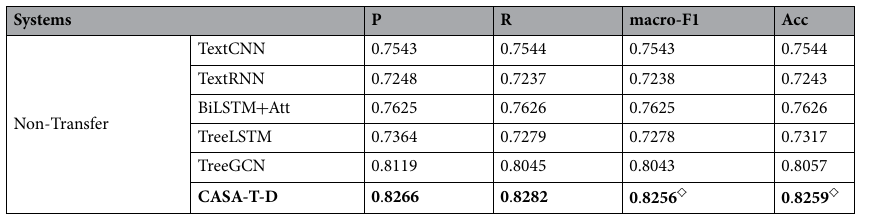
Table 2. Model comparison results. The state-of-the-art result of each evaluation indicator is bolded. The marker ♦ refers to p-value < 0.05 when compared with TreeGCN in the paired t-test. All models run over five times with random initializations and are report average precision, recall, macro-F1, and